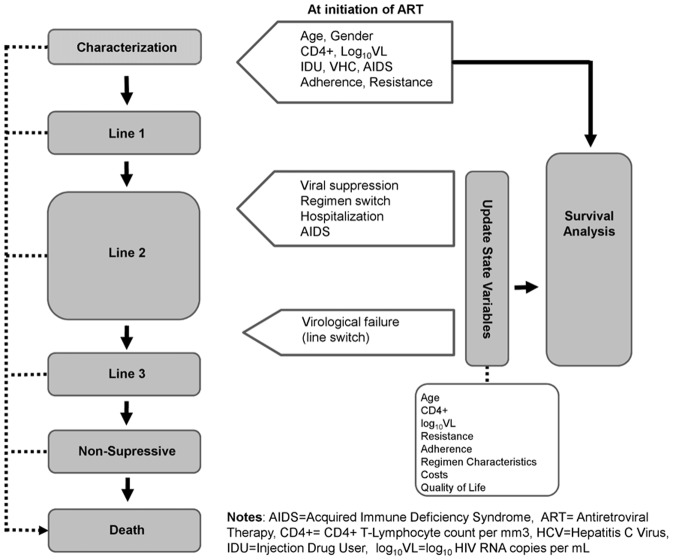
Discrete events microsimulation model diagram.